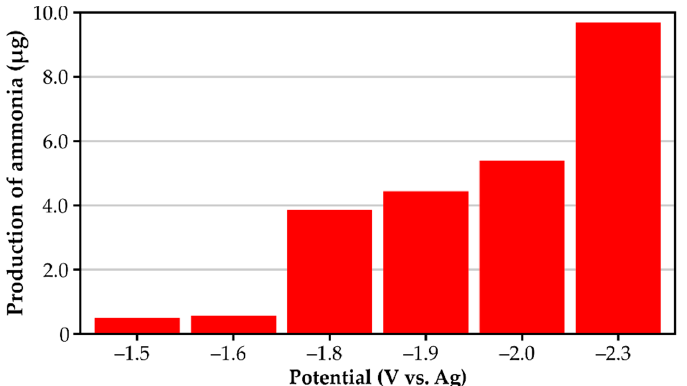
Figure 3. Results of 24 h electrocatalytic NH 3 production on glassy carbon using the working solution: 2 mM Cp 2 TiCl 2 , 0.1 M Bu 4 NClO 4 and 20 mM catechol in THF/MeOH (9:1) with constant N 2 flow. Table 2. Results of catalytic nitrogen reduction on glassy carbon electrode using working solution containing titanocene complex as catalyst (Cp 2 TiCl 2 , 20 nM, 5 mg), electrolyte (n-Bu 4 NClO 4 , 0.1 M) and catechol additive (C 6 H 4 (OH) 2 , 10 equivalents, 0.2 mM, 22 mg) dissolved in THF/MeOH 9:1